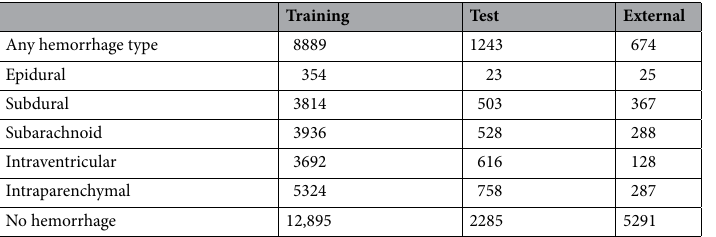
Table 1. Distribution of examination labels in the training, test, and external validation datasets according to hemorrhage types. The number of labels exceeds the actual number of examinations as more than one label may have been applied to each CT